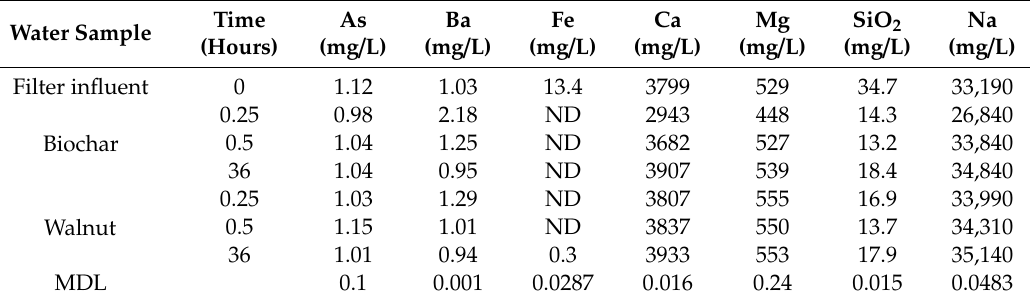
Table 3. Metal concentrations in filtrate from biochar and walnut column